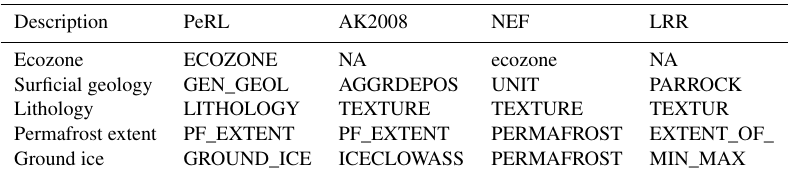
Table B4. Terminology for permafrost properties in the regional permafrost databases of Alaska (AK2008), Canada (NEF), and Rus- sia